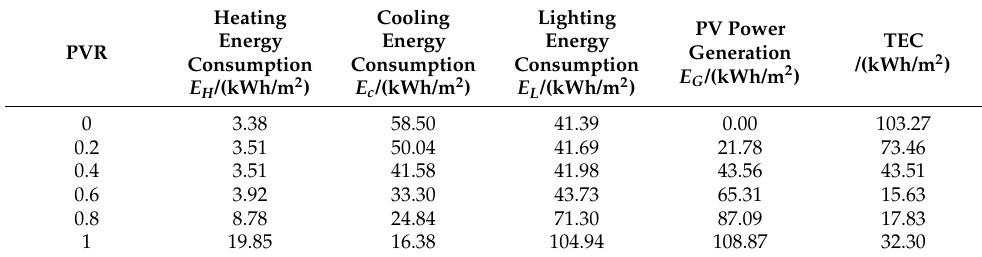
Table 2. The energy consumption values and